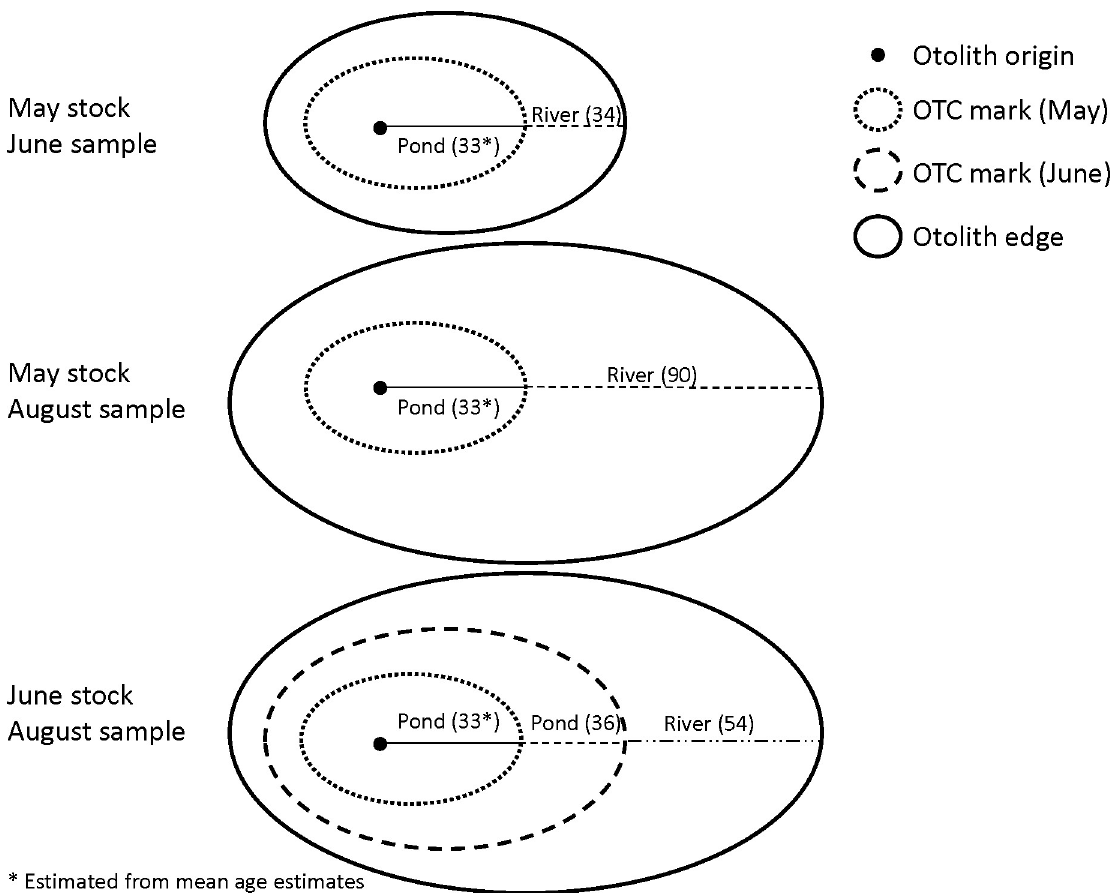
Fig 2. Illustration of oxytetracyline (OTC) marks and the known age (days) associated with each. For fish stocked in May and sampled in June, 33 days in the pond (estimated as the mean daily age from counts of rings in otoliths) and 34 days in the river elapsed. For fish stocked in May and sampled in August, 33 days in the pond and 90 days in the river elapsed. For fish stocked in June and sampled in August, 33 days in the pond elapsed in the pond until the first OTC marking episode, and another 36 days elapsed in the pond until the second OTC marking episode; 54 days elapsed between the time the fish were stocked in the river and subsequently sampled.